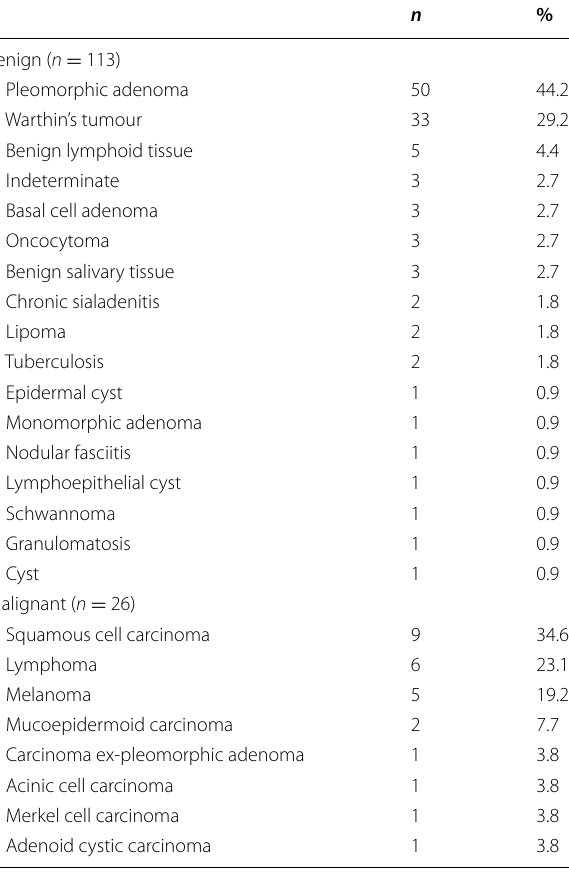
Table 1 Cytologic diagnosis of parotid gland tumours without histopathologic diagnosis